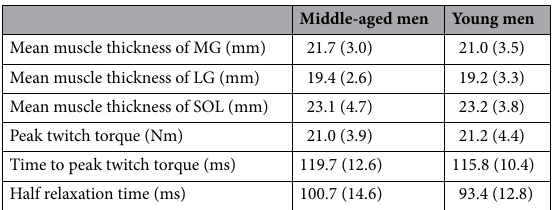
Table 1. Muscle thickness and twitch properties in middle-aged and young men Mean